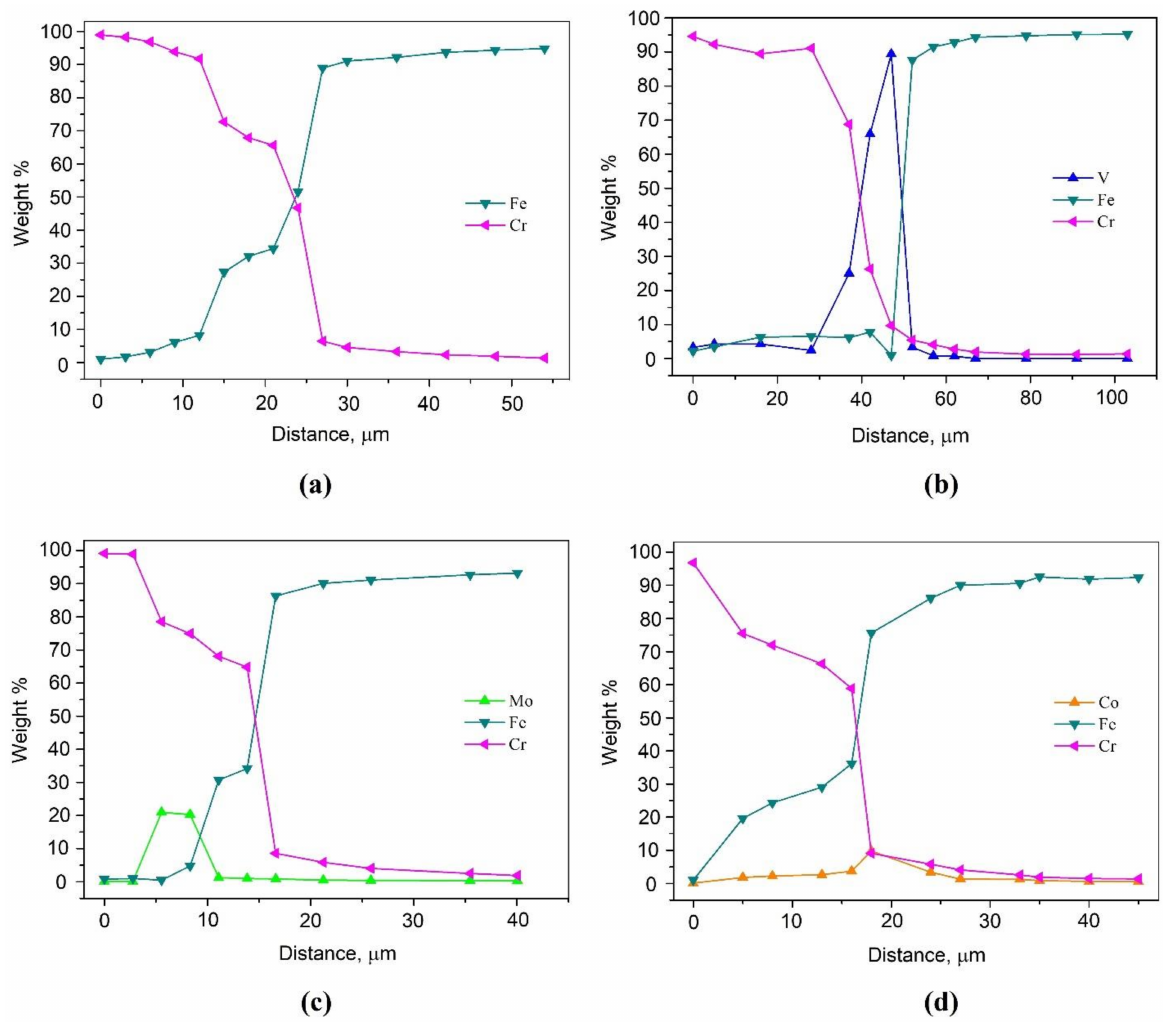
Figure 2. EDS line scan showing the distribution of the elements across the resulting layer after thermal diffusion chromium plating of the sample: ( a ) without additives; ( b ) with 5% FeV; ( c ) with 5% Mo; ( d ) with 5%